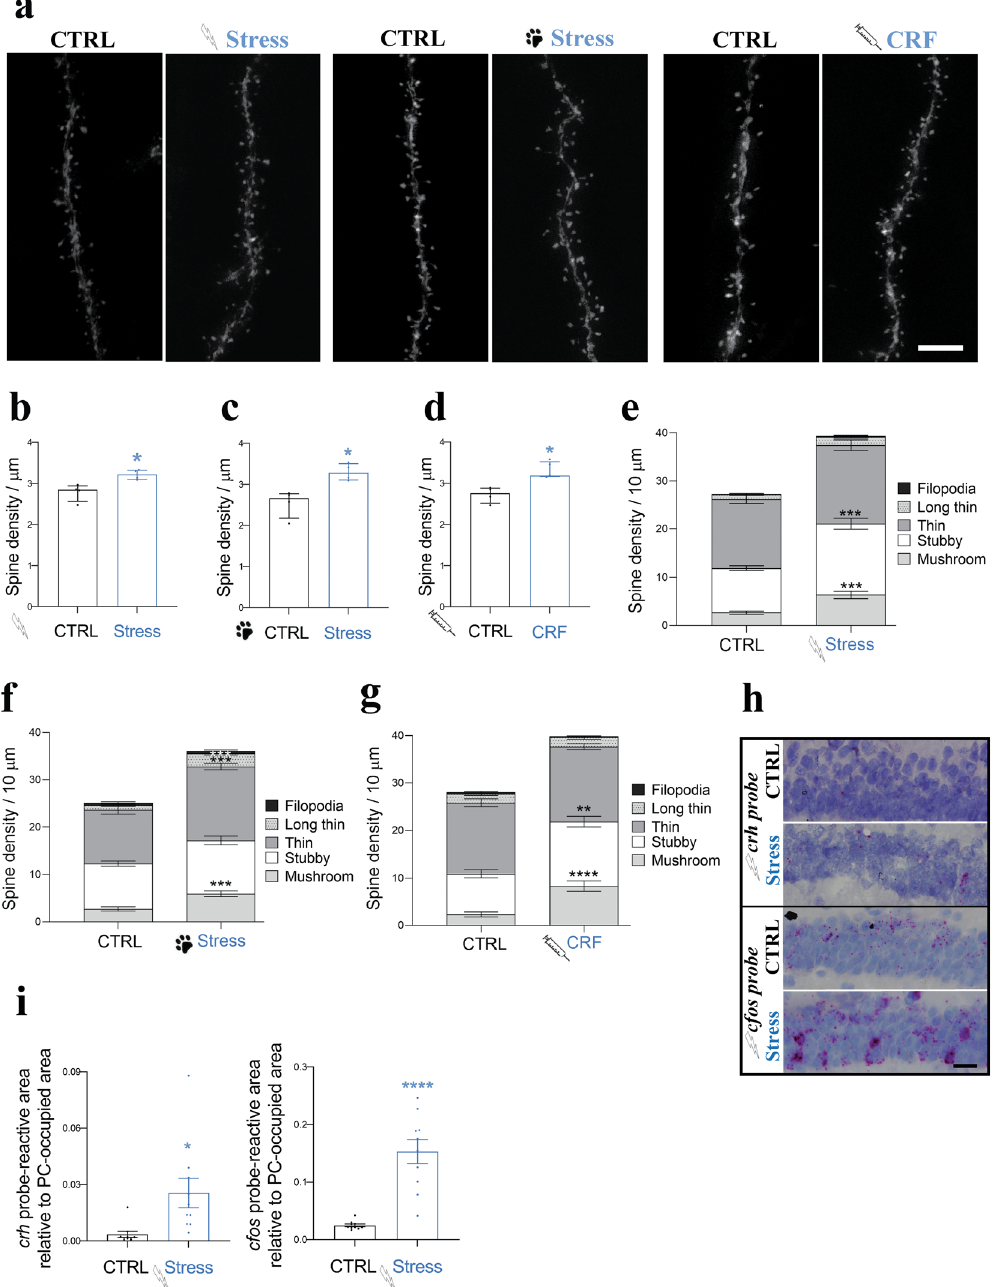
Fig. 1 Acute stress and CRF increase spine density in CA1 hippocampus in vivo. a Images of CA1 PC dendrites from Thy1-YFP mice before and after acute stress. Left two images: foot shock (FS) paradigm, middle two images: predator odor (PO) paradigm, right two images: 20 min 100 nM CRF treatment using stereotactic injections into the hippocampal formation. Scale bar = 5 µm. b – d Quanti fi cation of spine densities after FS, PO, and CRF treatment (shown as median with IQR, CTRL: N = 4 animals, n = 34 dendrites; FS: N = 4, n = 34; PO: N = 4, n = 31; acute CRF treatment: N = 5, n = 34; Mann – Whitney tested (U = 0); * p < 0.05). b Acute stress paradigms FS, c PO and d acute CRF treatment increase spine density. e – g Quanti fi cation of spine types. e Acute stress paradigms FS (shown as mean ± SEM, CTRL: N = 4, n = 19; FS: N = 5, n = 18; multiple t -test ( fi lopodia; t ratio = 0.6804, long thin; t ratio = 2.696, thin; t ratio = 1.513, stubby; t ratio = 4.728, mushroom; t ratio = 4.363). *** p < 0.0001). f PO (shown as mean ± SEM, CTRL: N = 5, n = 18; PO: N = 4, n = 18; multiple t -test fi lopodia; t ratio = 0.2124, long thin; t ratio = 4.100, thin; t ratio = 4.141, stubby; t ratio = 0.9460, mushroom; t ratio = 4.868). *** p < 0.0005) and g acute CRF treatment (shown as mean ± SEM, CTRL: N = 3, n = 14; CRF injections: N = 3, n = 15; multiple t -test fi lopodia; t ratio = 0.8867, long thin; t ratio = 0.2817, thin; t ratio = 0.9384, stubby; t ratio = 3.645, mushroom; t ratio = 4.784). ** p < 0.005) promote spine maturation in PCs CA1. h FS increases crh (left) and cfos (right) mRNA expression in CA1 PCs. Scale bar = 25 µm. i Quanti fi cation of crh (left) (shown as mean ± SEM from FS CTRL: N = 4, n = 10 sections; FS: N = 4, n = 10; unpaired t -test (t = 2.765, df = 18). * p < 0.05) and cfos (right) mRNA expression (shown as mean ± SEM from FS CTRL: N = 3, n = 10 sections; FS: N = 3, n = 10; unpaired t -test (t = 6.122, df = 18). **** p <